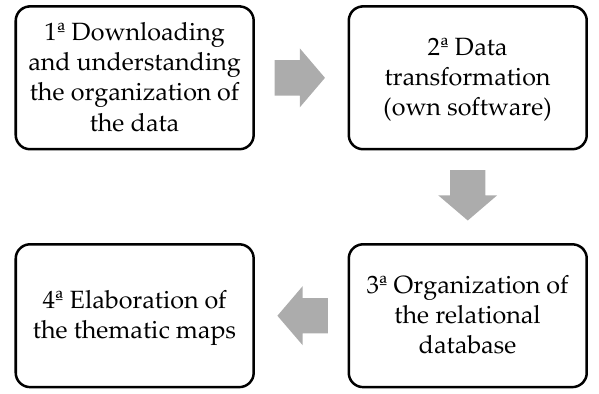
Figure 1. Methodology for processing the CAT files.